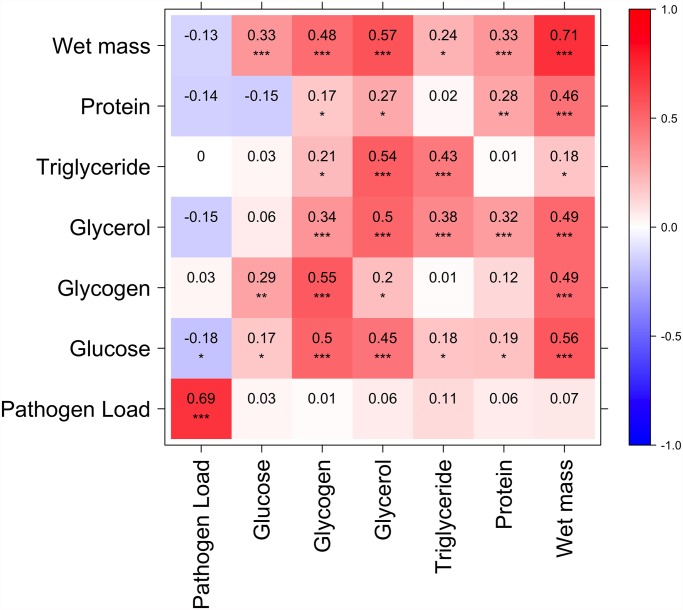
Correlation between nutritional indices and immune defense (Ln CFU per fly).Diagonal represents correlation for each index between high and low glucose diets; above diagonal is correlation among indices on the high glucose diet; below diagonal is correlation among indices on the low glucose diet. p<0.0001***, p<0.001**, p<0.05*. Several nutritional indices are correlated with each other but only glucose on the high glucose diet is significantly (negatively) correlated with immune defense.